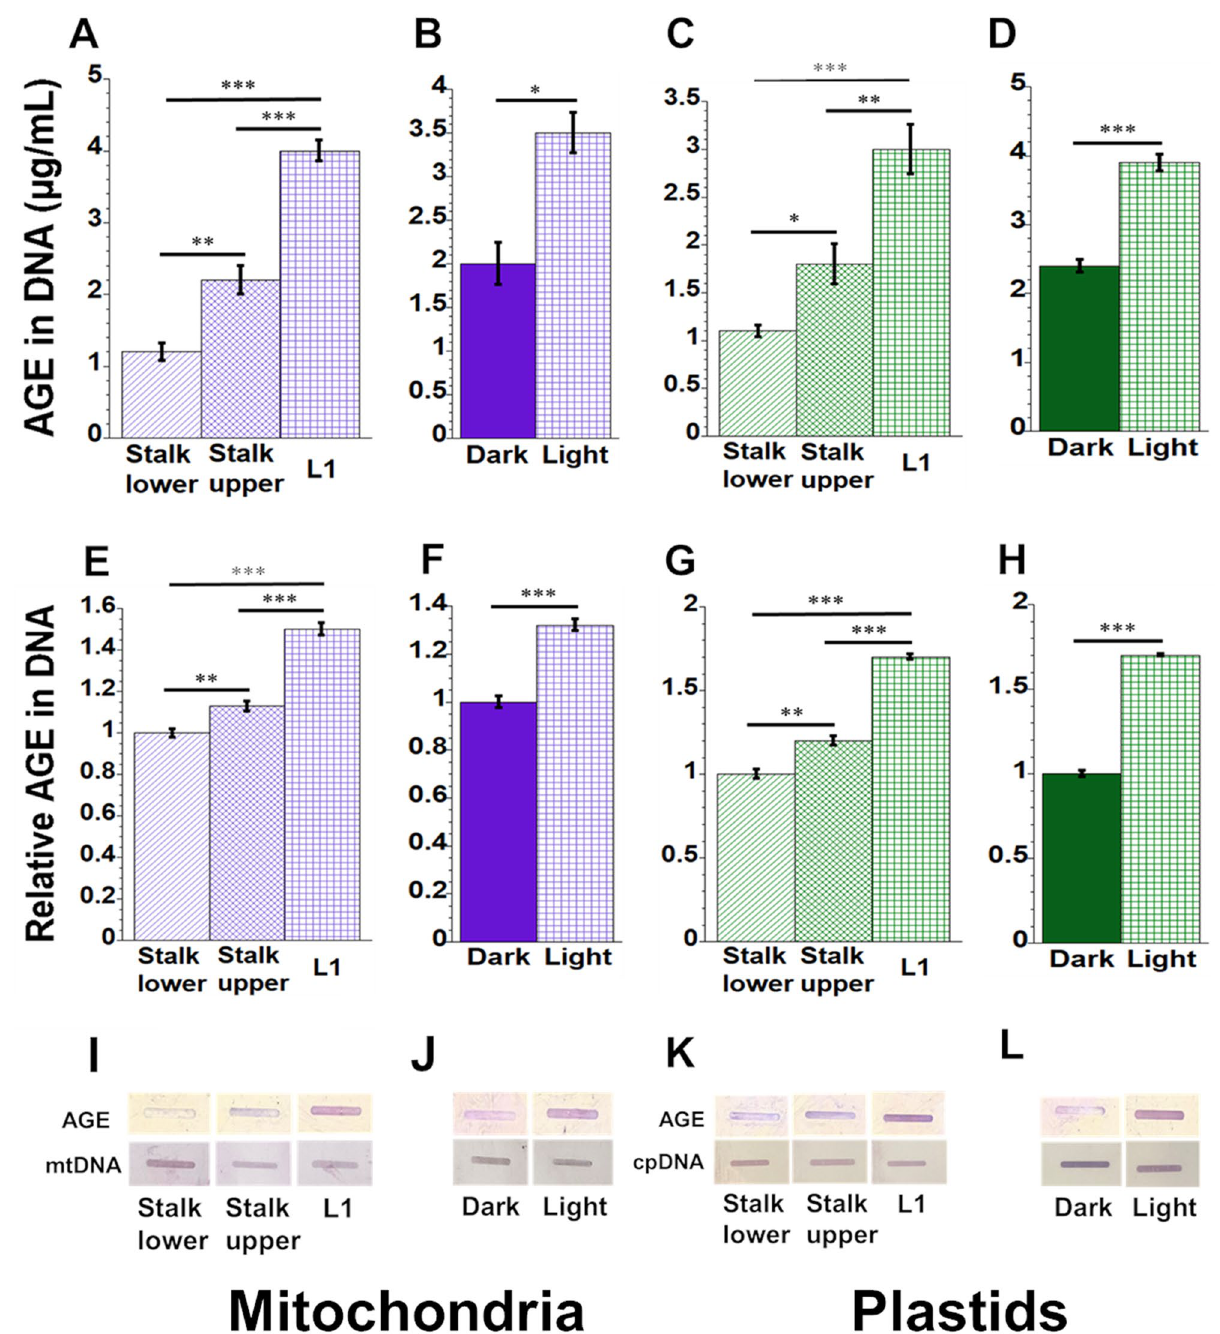
Figure 6. AGE in DNA isolated from mitochondria and plastids. For competitive ELISA assays ( A – D ), AGE levels were determined as µg/mL. The relative levels of AGE were also determined by slot blot assays ( E – H ), and representative images are shown ( I – L ) where the image intensity was set to 1 for Stalk lower in ( E , G ) and for dark-grown leaves in ( F , H ). Equal amounts of mtDNA extracted from the different tissues were used in these assays. Lower panels of ( I – L ) show the equal amount of orgDNA as determined by slot blot using mitochondrial- and plastid-specific probes (cox2 and rbcL, isolated from L1 than from Stalk lower (Fig. 6C) and 1.6 times more AGE residues for light-grown than dark- grown leaves (Fig. 6D), as determined with the ELISA assay. We found similar results from the slot-blot assay where the relative intensity of the AGE in DNA was 1.5-fold higher in mtDNA from L1 than from Stalk lower (Fig. 6E). Similarly, the light-grown leaves had 1.3 times more AGE in DNA than dark-grown leaves (Fig. 6F). In the plastid slot-blot assay, the relative level of AGE residues attached to ptDNA was 1.7-fold higher in L1 than in stalk lower (Fig. 6G); and for light-grown leaves, it was 1.7 times higher than for dark-grown leaves (Fig. 6H). Representative images of mtDNA and ptDNA slot blots are shown by Figs. 6I-L.